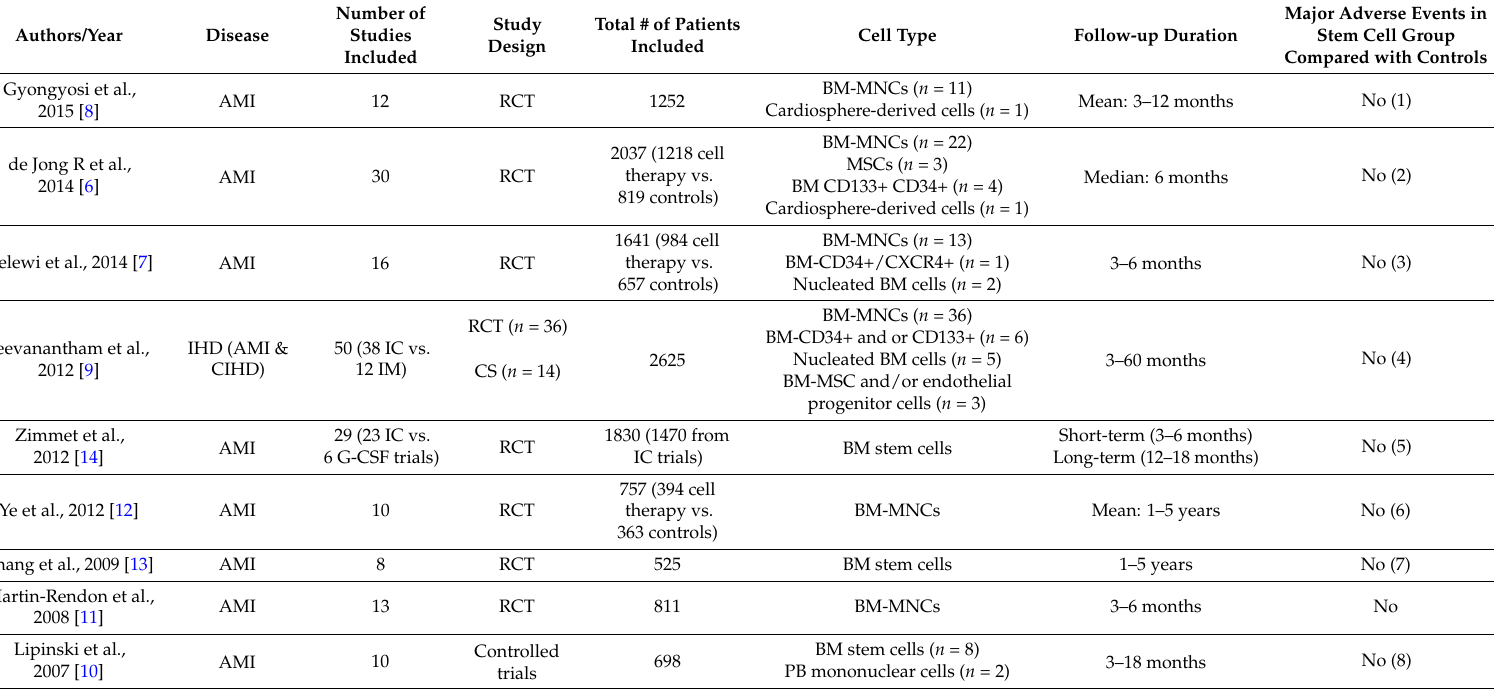
Table 2. Summary of meta-analysis studies for intracoronary stem cell transplantation in acute ischemic heart